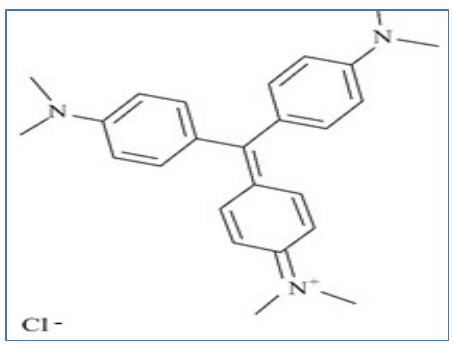
Figure 8. Structure of basic crystal violet (CV) dye.